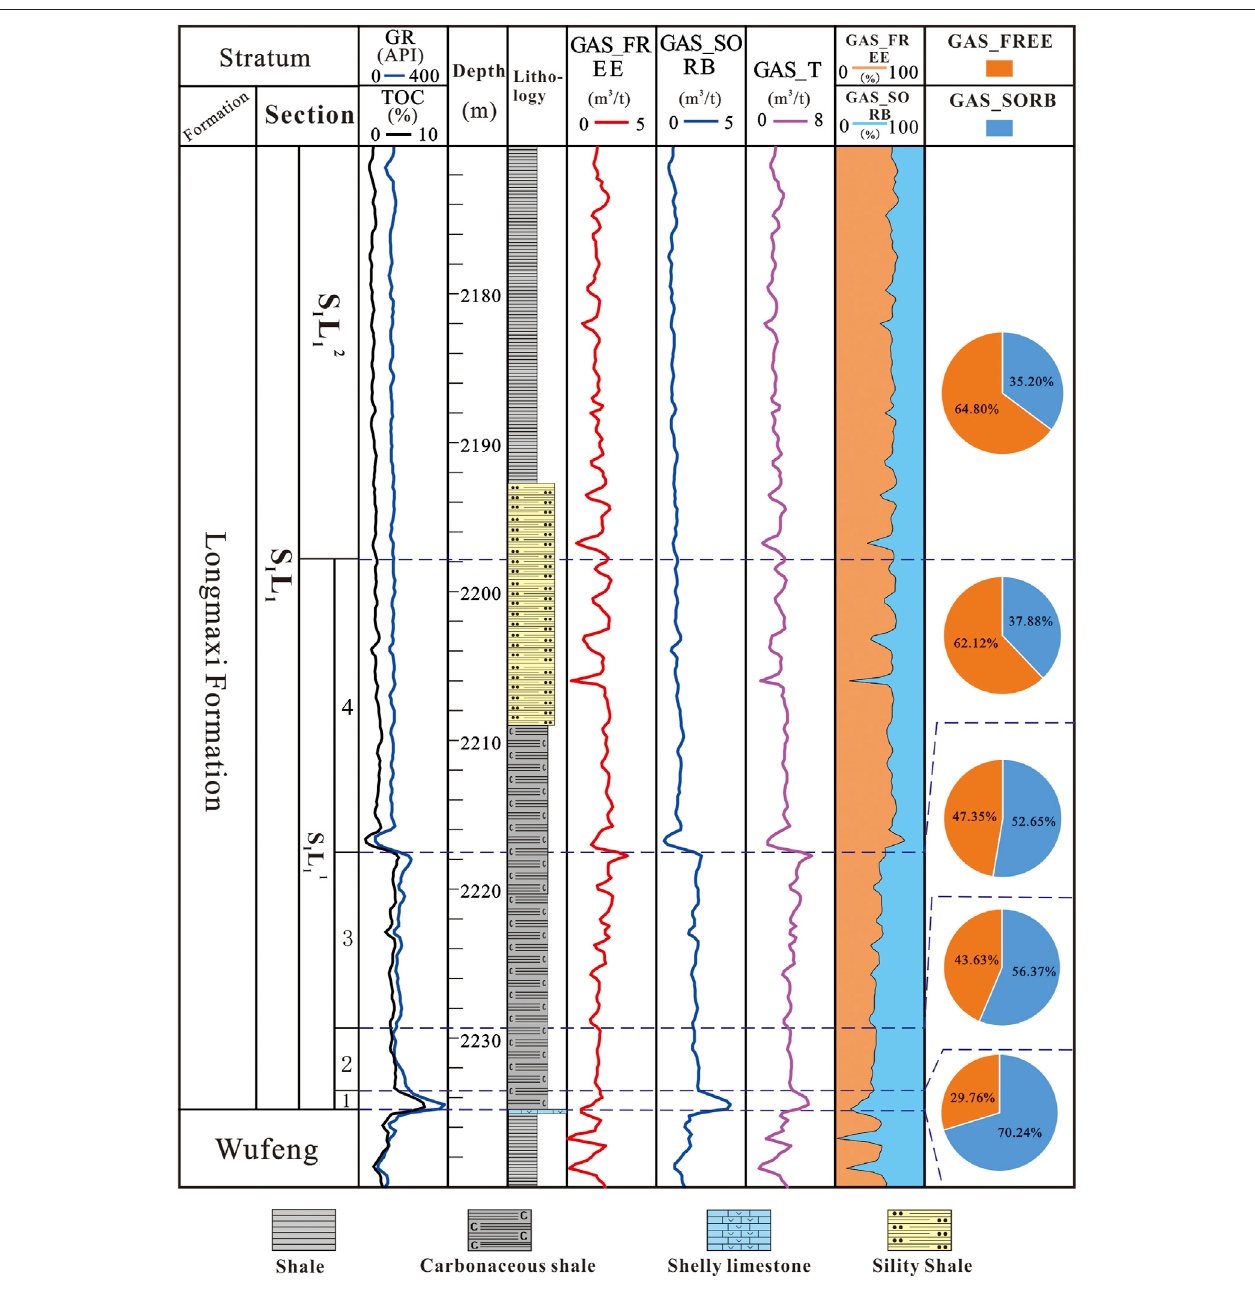
FIGURE 4 | The free gas and adsorbed gas content of the Longmaxi Formation in X10 well.